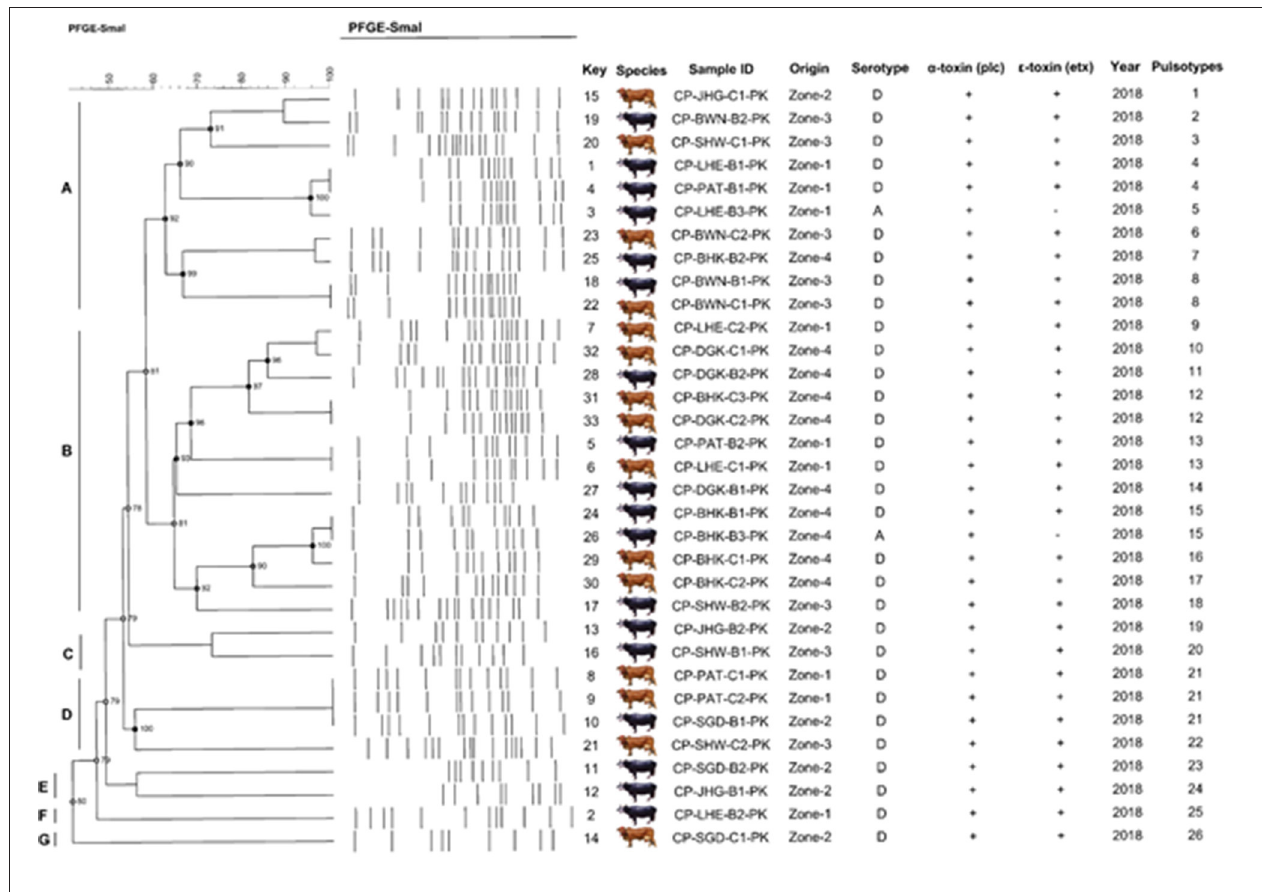
FIGURE 7 | Schematic representation (genetic profile, key species, isolate, serotype, toxinotypes, and pulsotypes) of 33 C. perfringens isolates obtained from buffalo and cattle in Pakistan. The macro-restriction pattern was conducted with SmaI. Dendogram obtained using BioNumerics 7.6 software and unweighted pair group method with Arithmetic mean. Letters (A–G) represents the C. perfringens toxinotypes prevalent in